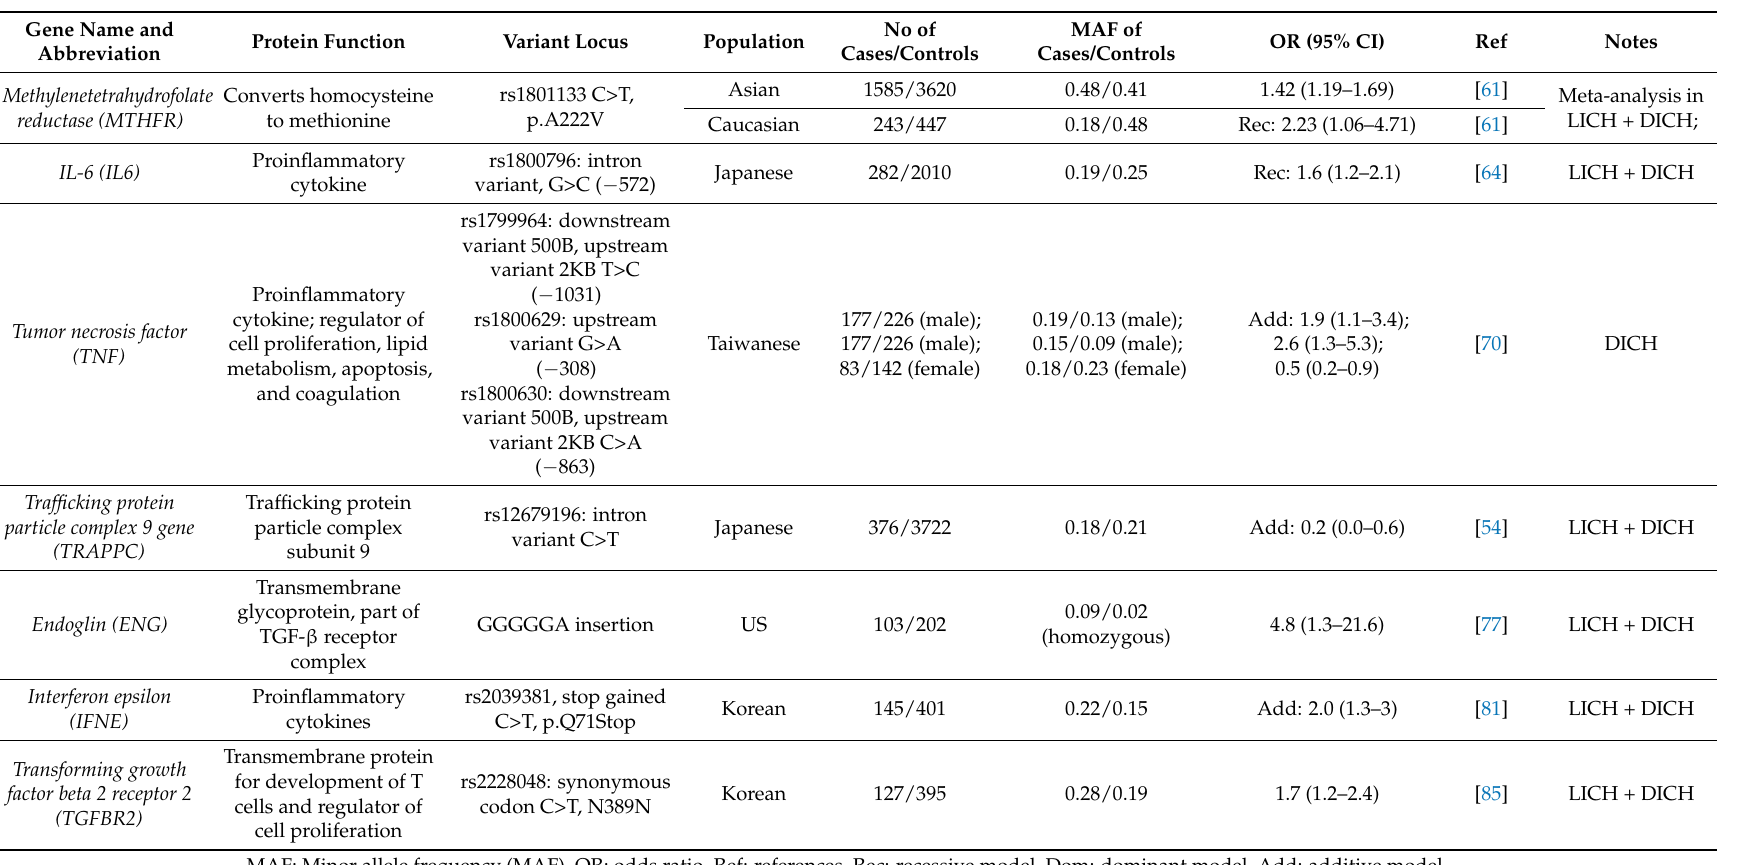
Table 3. Variants associated with ICH: